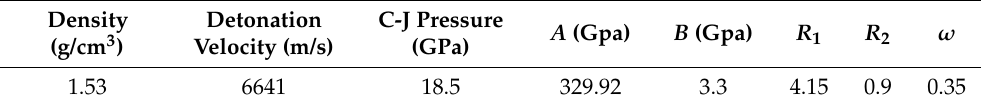
Table 3. Material parameters of TNT explosive.